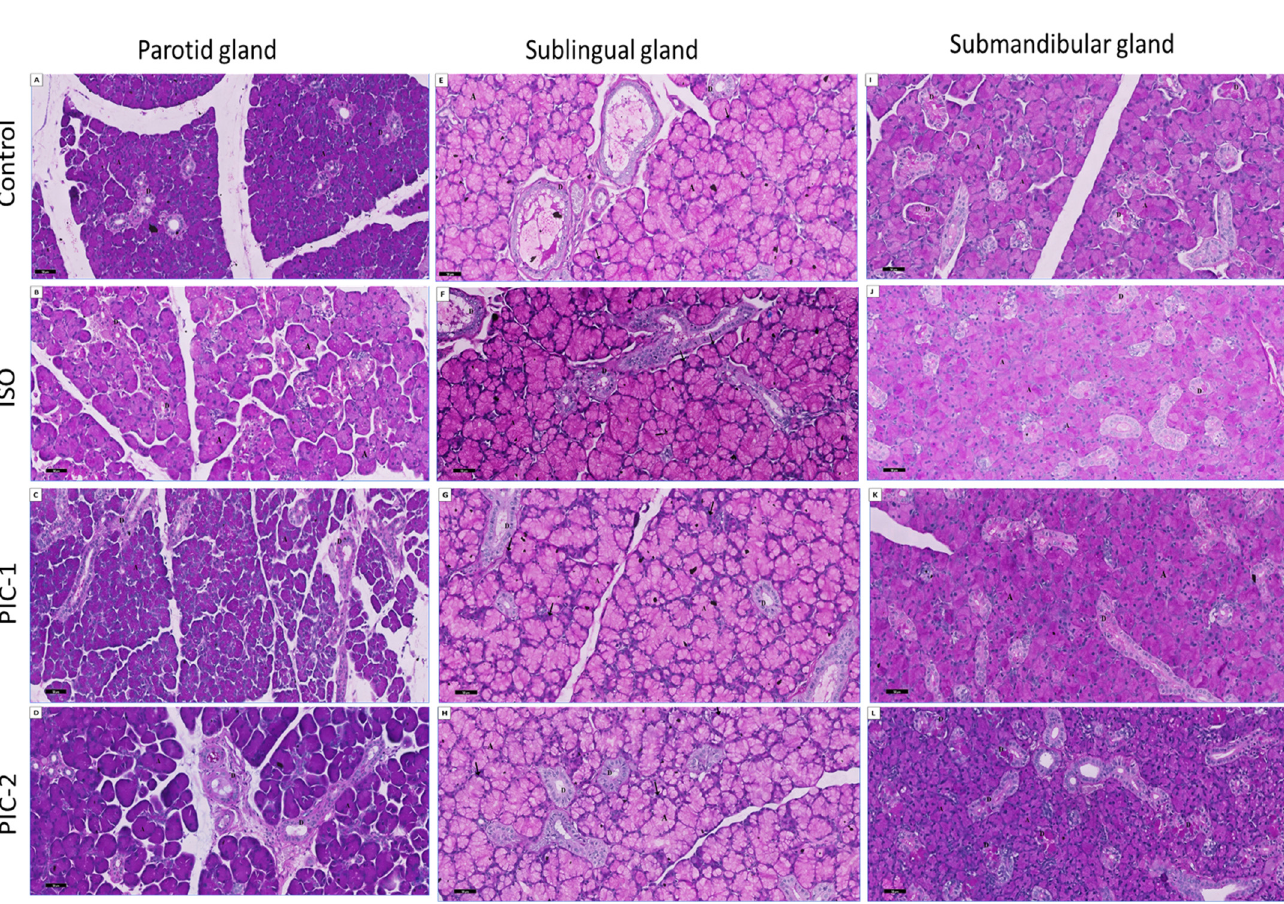
Figure 7. Sections of the three salivary glands (parotid ( A – D ), sublingual ( E – H ), and submandibular ( I – L ) glands) are stained with Alcian blue for Periodic Acid-Schiff (PAS) for identification of neutral mucin and counterstained with Hematoxylin. Sections in the parotid and submandibular salivary gland of control groups and in the low dose PIC-1 and high dose PIC-2 treated groups show strong positive PAS reaction (magenta color), appear in both ducts (D) and acini (A) which is observed more at their basement membrane. However, ISO treated group reveal faint positive PAS reaction in both the acini and the ducts. Most of acinar cells of the sublingual gland of control group exhibit faint positive magenta color reaction in the secretory acini (A) and the lumen of ducts (D) and strong positive reaction in the demilunar cells ( ↑ ). However, the ISO treated group shows a strong positive reaction in the secretory acini and the lumen of ducts. Demilunar cells show evident faint positive reaction. Interestingly, low dose PIC-1 and high dose PIC-2 appear nearly as control group compared to the previous groups. The duct cells show a slight increase in the intensity of PAS compared to the ISO treated group (PAS; ×200).